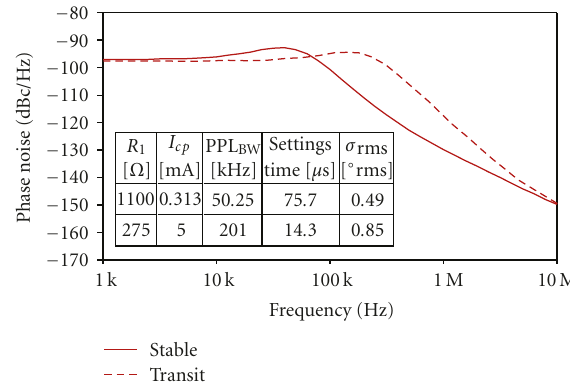
Figure 11: Phase noise performance at 3.59 GHz. Dashed line corresponds to the noise behaviour at the PLL output during the frequency transition (wideband mode).